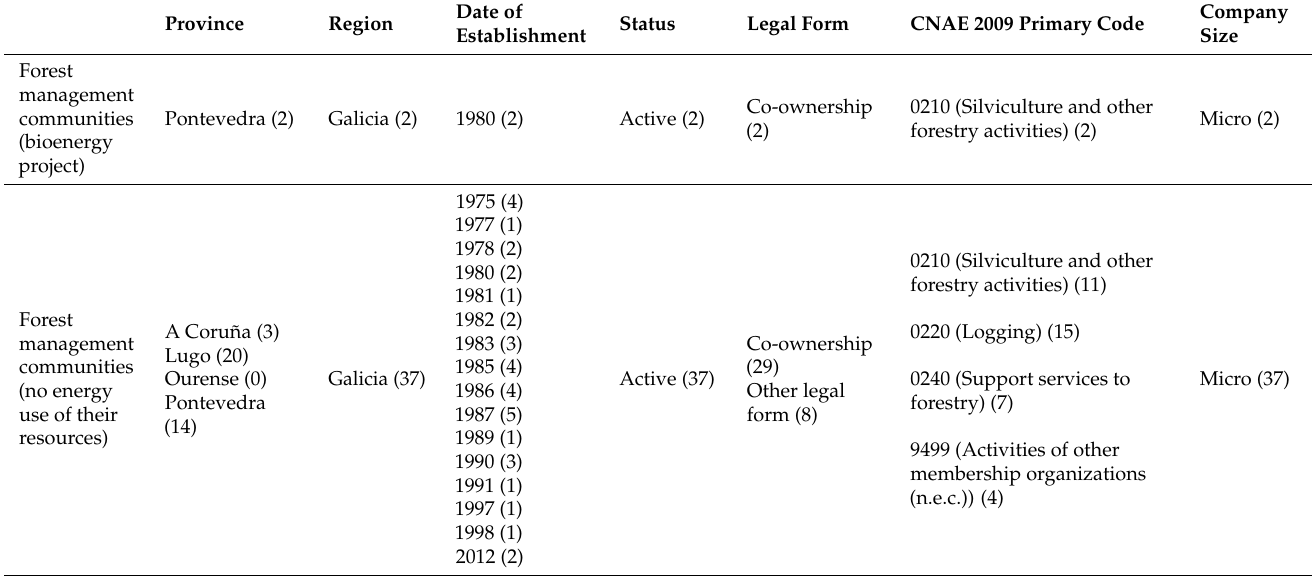
Table 1. Descriptive data obtained from two groups of forest management